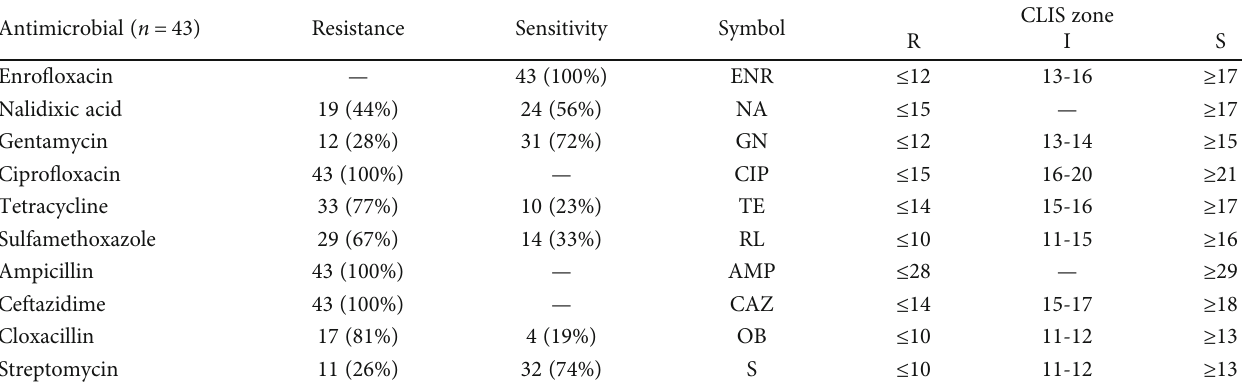
Table 4: Antimicrobial resistance pattern of Salmonella species isolated from intestinal contents and ready-to-eat chicken gizzards. Antimicrobial ( n = 43